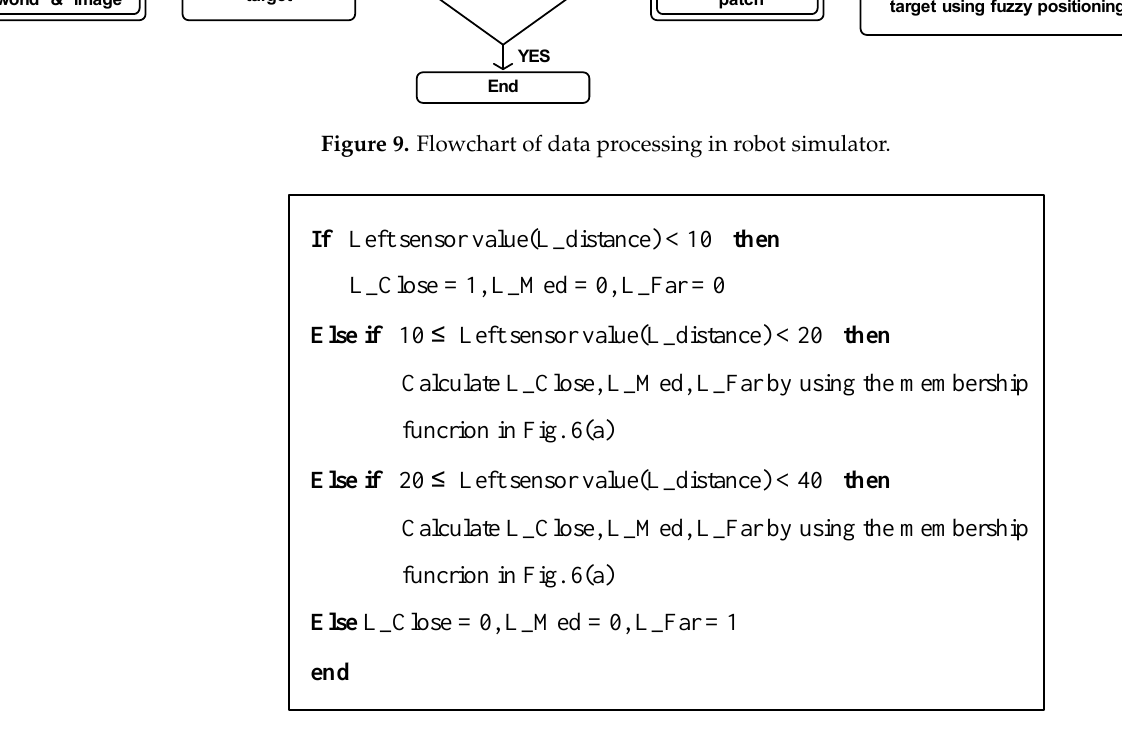
Figure 10. Sensor data fuzzification algorithm.